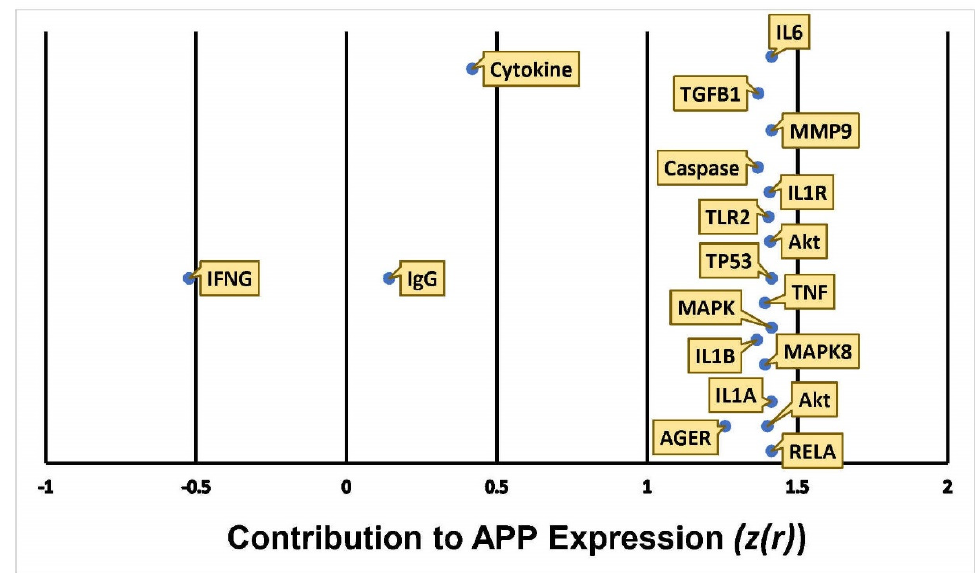
Figure 8. Quantitative illustration of APP expression in response HMGB1 upregulation. The over-